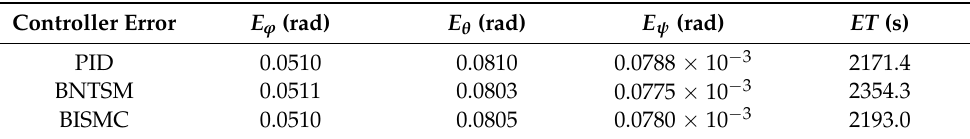
fault compensation.